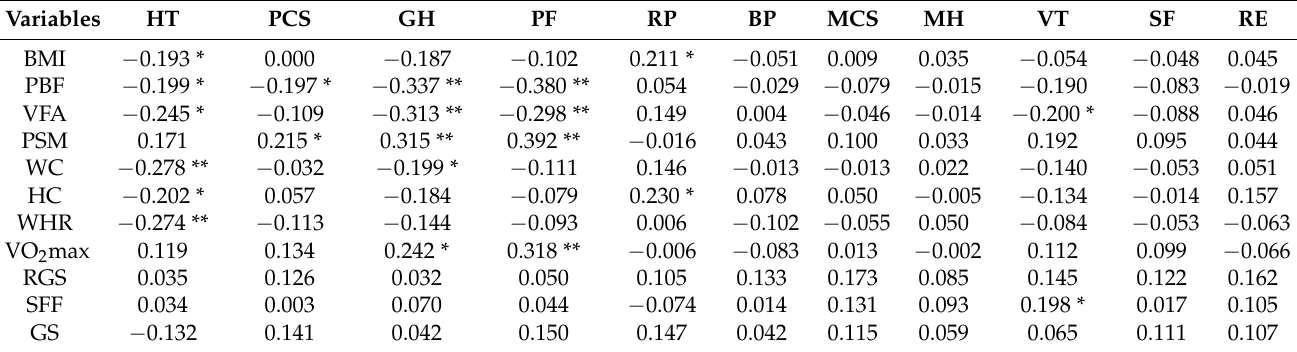
Table 3. Correlation between health-related fitness and QoL (N =